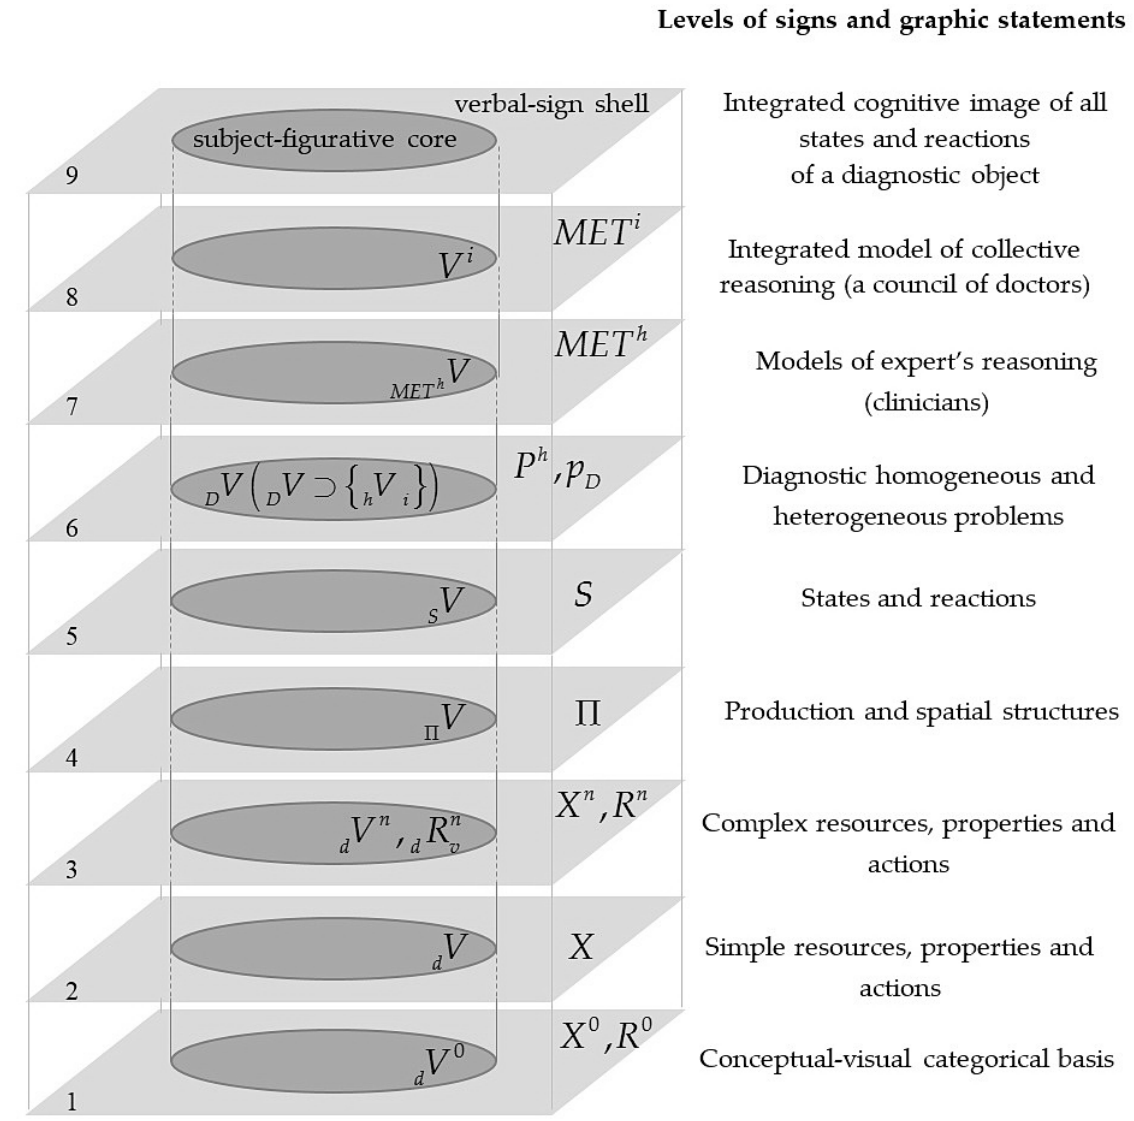
Figure 1. Visual metalanguage.